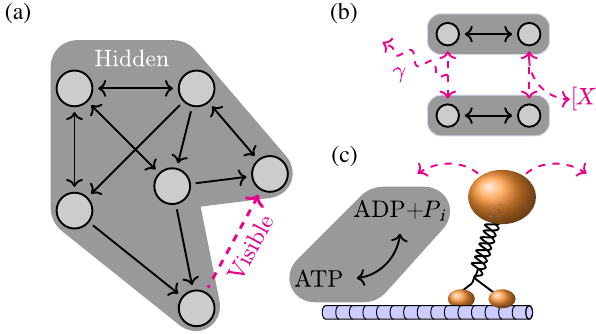
FIG. 1. Illustrations of the partial information acquired by an apparatus that can only detect a few visible transitions. (a) Setup of our framework, for the case of only one visible transition. A physical system performs a Markov-jump process in a network of states (circles), all of which are hidden from an external observer. The observer can only see occurrences of a few visible transitions (one, in this example), while the rest of the transitions remain hidden during the data acquisition (black shaded area). (b,c) Model examples described by our theory: (b) photon emission or absorption γ and synthesis or consumption of chemical species X that signal the occurrence of some transitions, and (c) a molecular motor performing steps along a track and transitions related to spatial motion along the track, detected by monitoring the position of the cargo (orange sphere), with chemical fuel consumption (ATP hydrolysis) often remaining hidden (gray box); see also Fig.